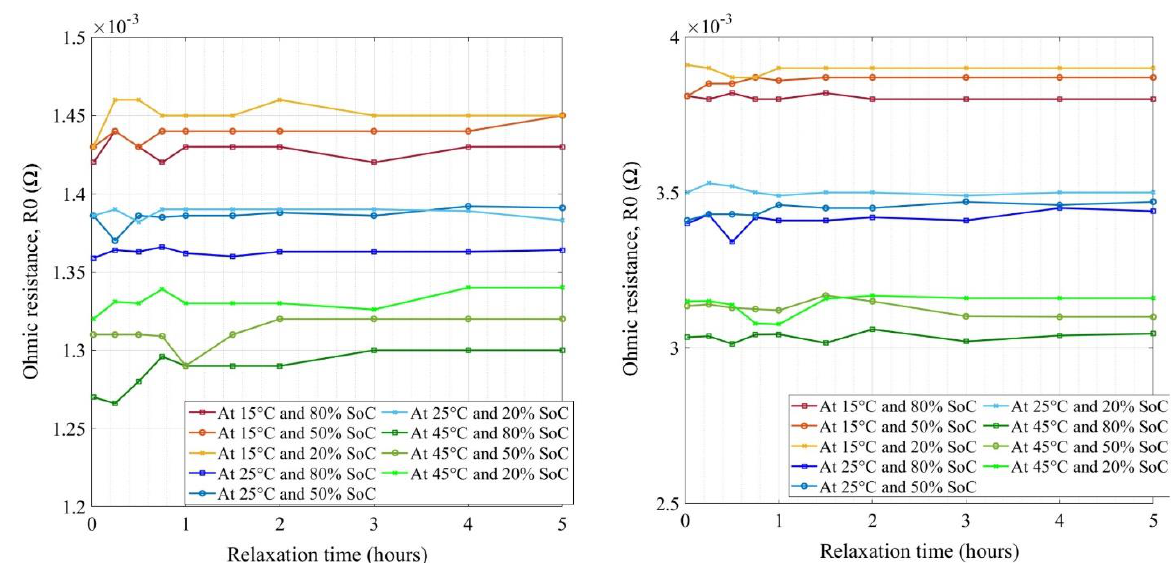
Figure 7. Ohmic resistances for new ( left ) and aged ( right ) NMC cells.